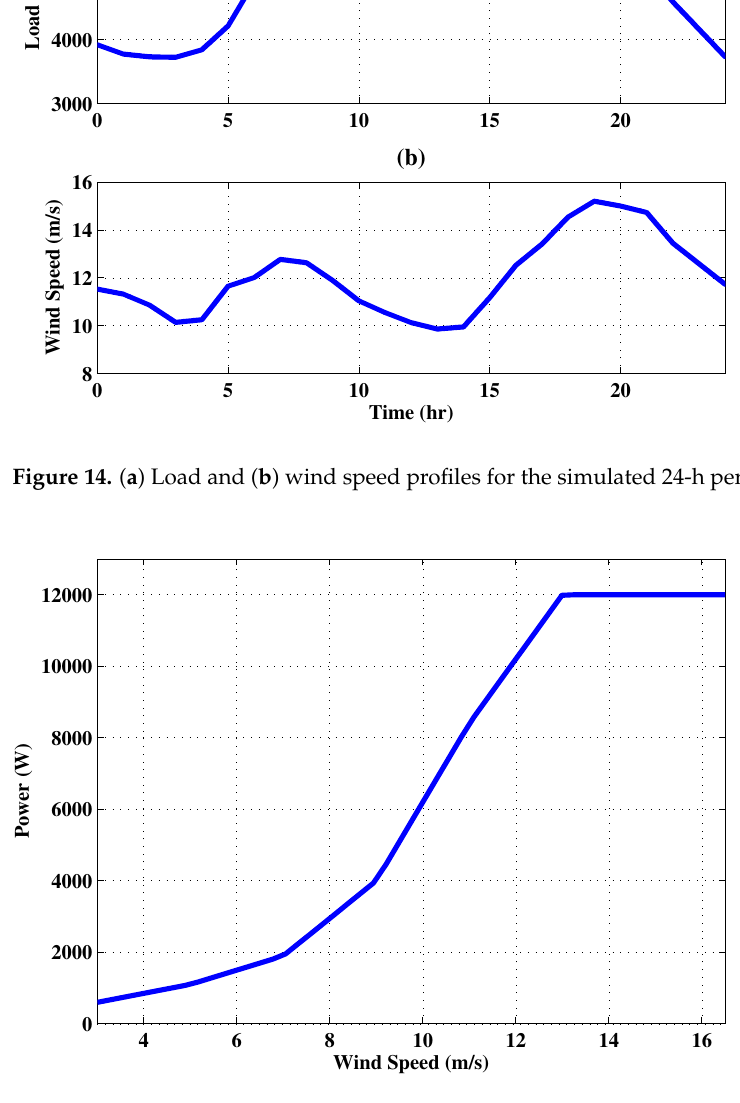
Figure 15. Power curve for the 12-kW wind